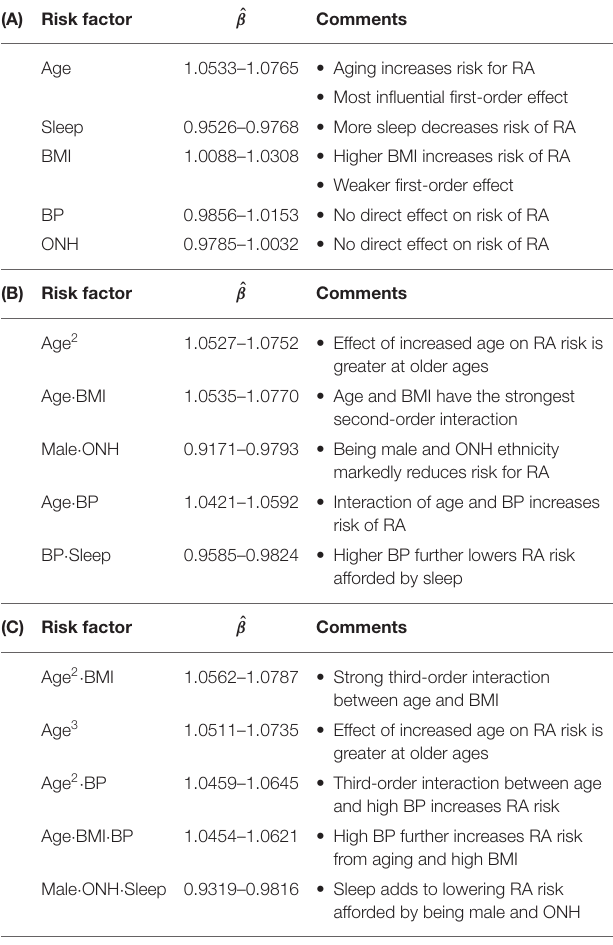
TABLE 4 | Summary of key findings for (A) first-order, (B) second-order, and (C) third-order